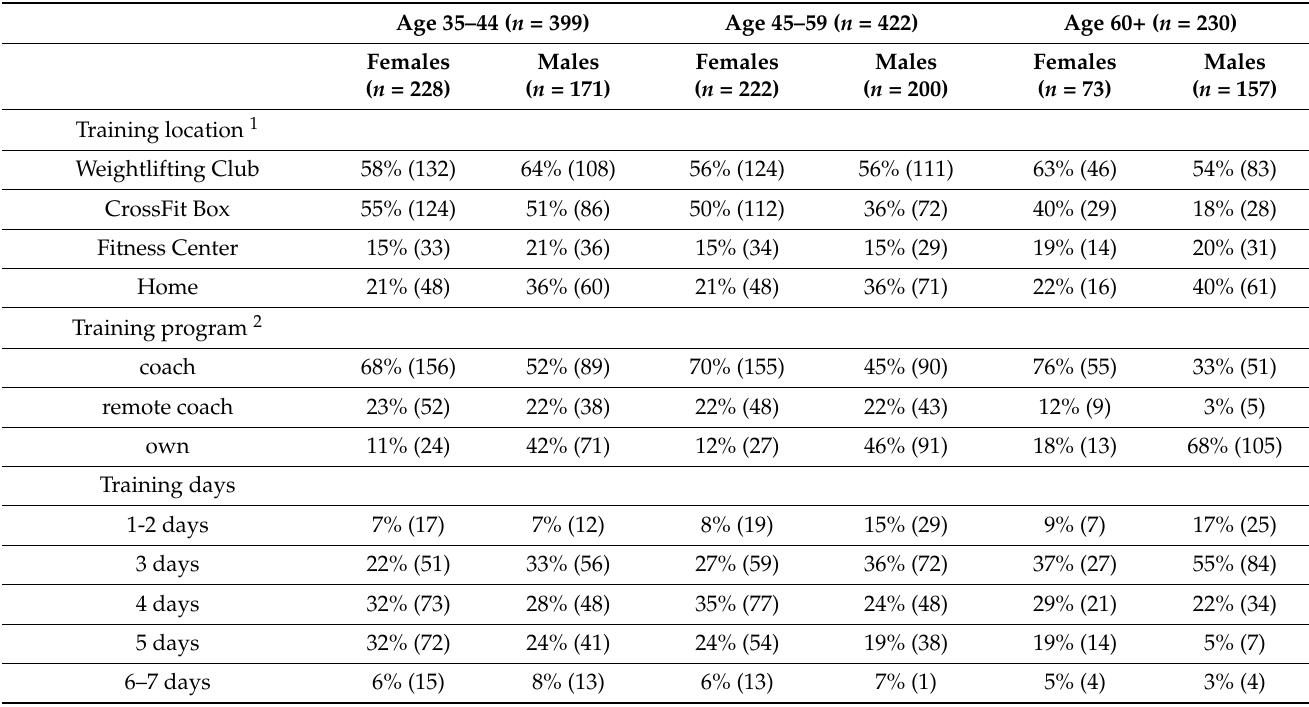
Figure 1. Distribution of age at start of weightlifting in North America (USA + CAN) and Europe (EUR). Table 2. Training variables by age and